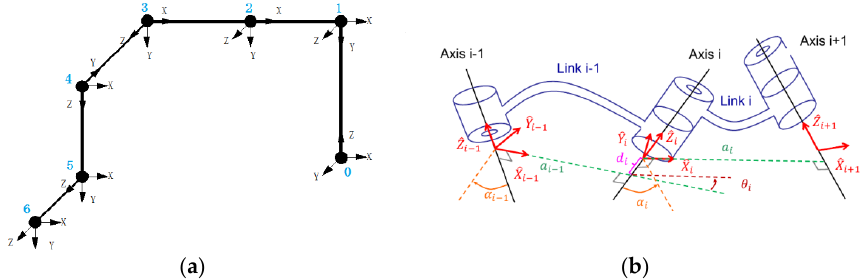
Figure 11. T tool , T dis , and the 9 axes of the UR5 robot system. Figure 12a is the structural diagram of the 6-DOF UR5 robot composed of 6 revolute pairs, represented by 1, 2, 3, 4, 5, and 6 and 0 represents the end fixture of the UR5 robot. In order to analyze the pose change of the UR5 robot’s end fixture coordinates relative to the end-effector, the D-H model is harnessed to establish the kinematics forward solution model of the UR5 robot.